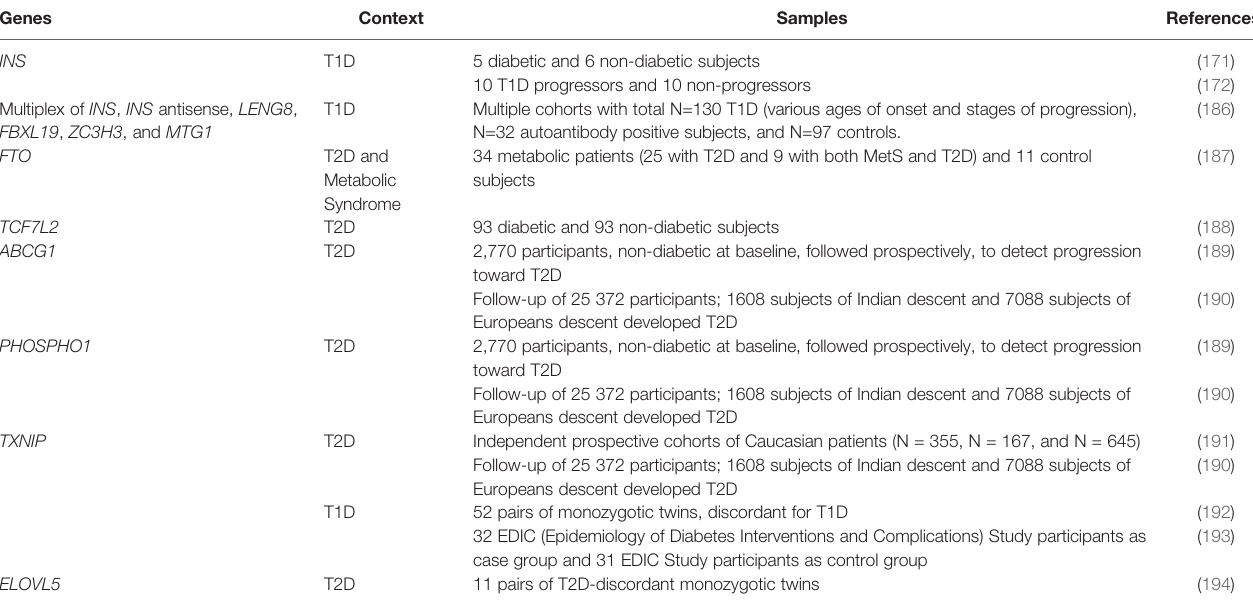
TABLE 3 | Blood-based biomarker candidates T1D and